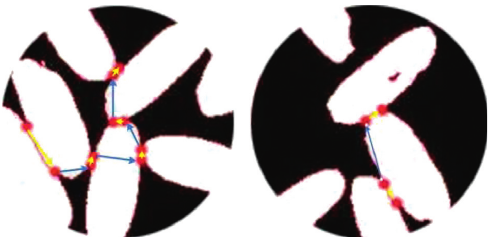
Figure 10: Ant colony algorithm path planning